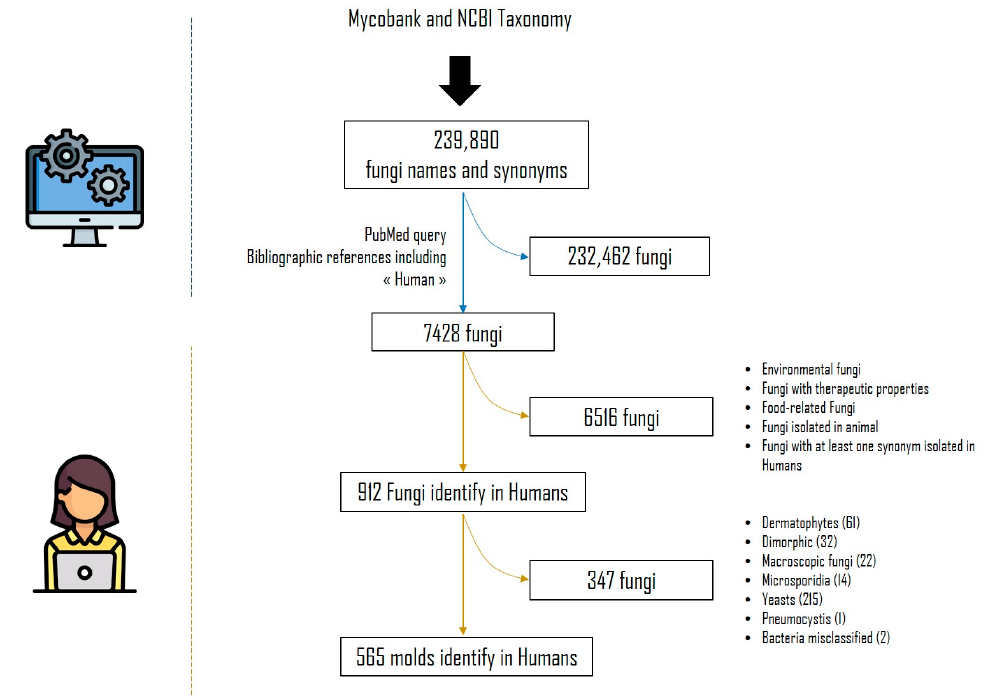
Figure 1. Systematic literature review fl owchart.